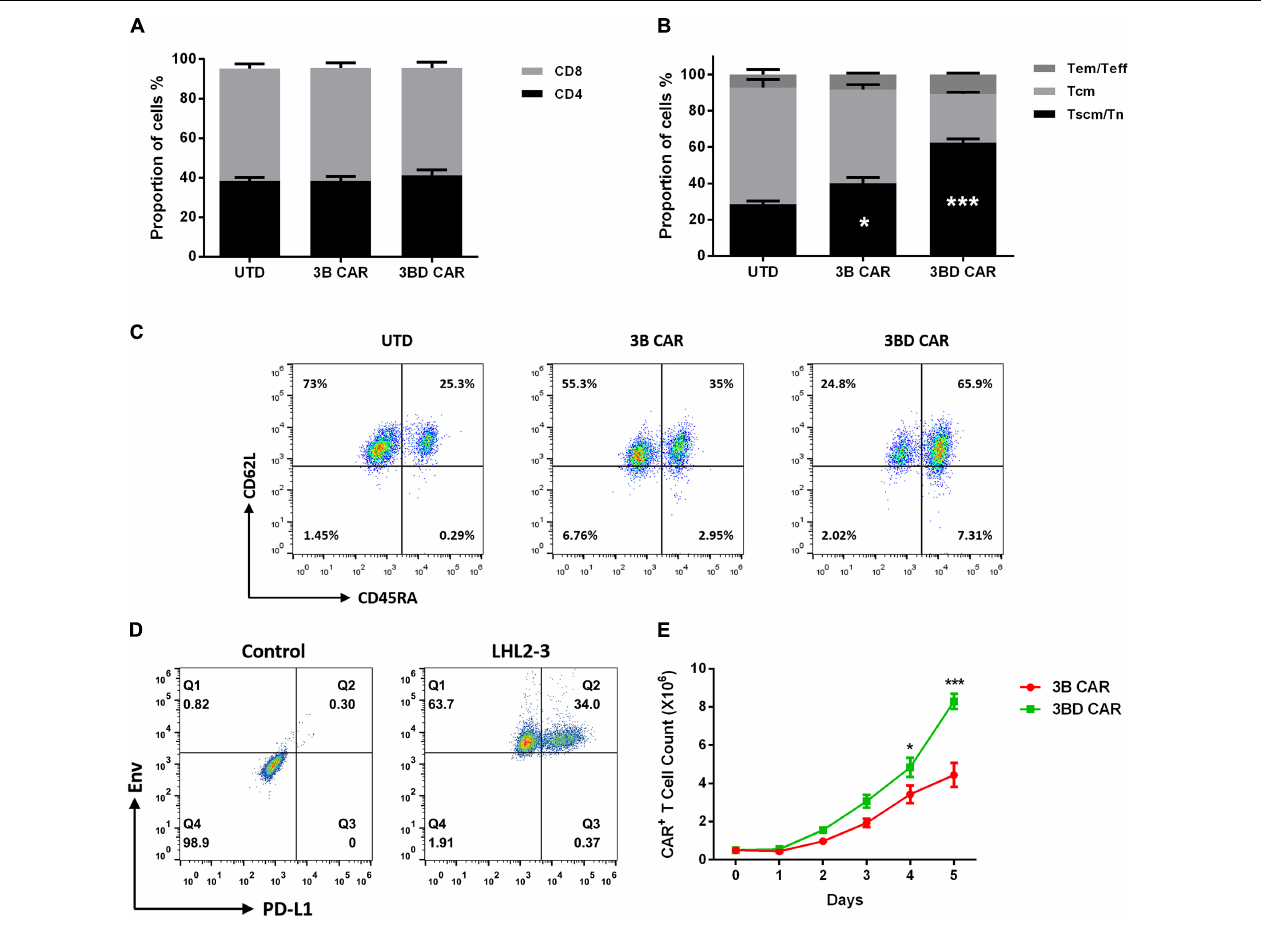
FIGURE 2 | 3BD CAR-T cells displayed preferable immunophenotype and proliferation. (A) Proportions of CD4 + and CD8 + T cells in UTD/3B/3BD CAR-T cells. The subset composition of UTD/3B/3BD CAR-T cells were measured by surface expression of CD45RA and CD62L. Shown are summary data (B) and representative flow plots (C) for indicated CAR groups (combined data from three independent experiments evaluating 3 donors; asterisks indicate significant differences from UTD). T n /T scm (CD45RA + CD62L + ), T cm (CD45RA − CD62L + ), T em /T eff (CD62L − ). Data in B was analyzed using two-way ANOVA. (D) Flow cytometry was performed to detect the expression of Env and PD-L1 in LHL2/3 cells. (E) 3BD CAR-T cells demonstrated enhancement in accumulation. CAR-T cells sorted for CAR expression were incubated with LHL2/3 cells (5 × 10 5 cells) at 1:1 ratio for 5 days, and CAR + cells were counted daily to evaluate the in vitro proliferation. Statistical significance was determined using the unpaired Student’s t -test. * p < 0.05, *** P < 0.001. Data represent the mean ± SEM of independent samples.